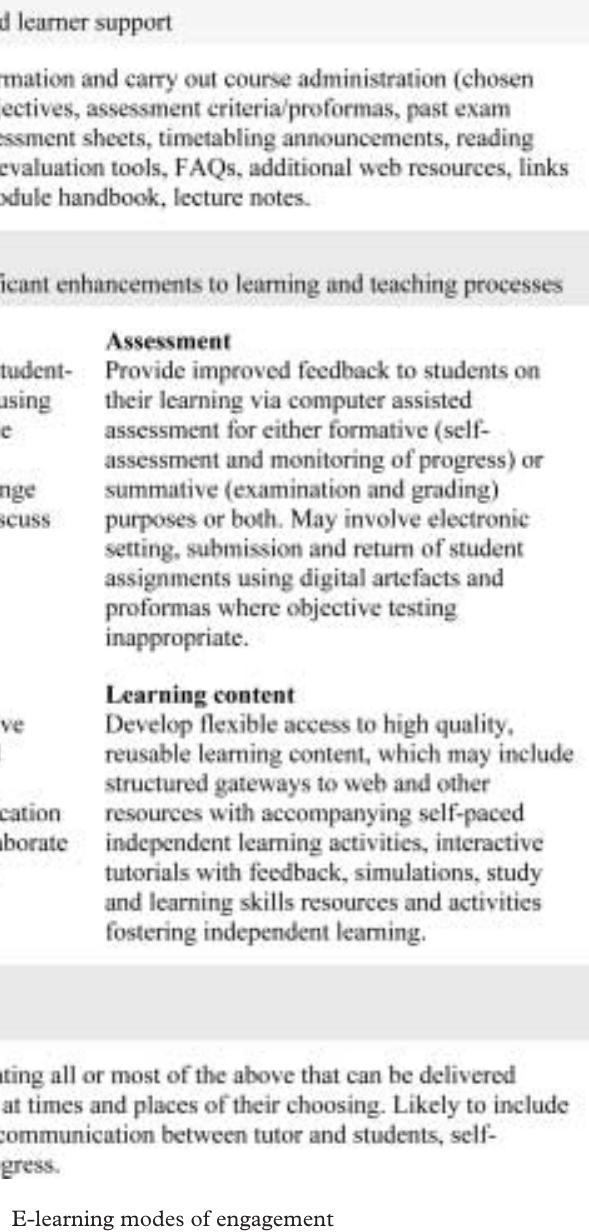
Figure 1. E-learning modes of